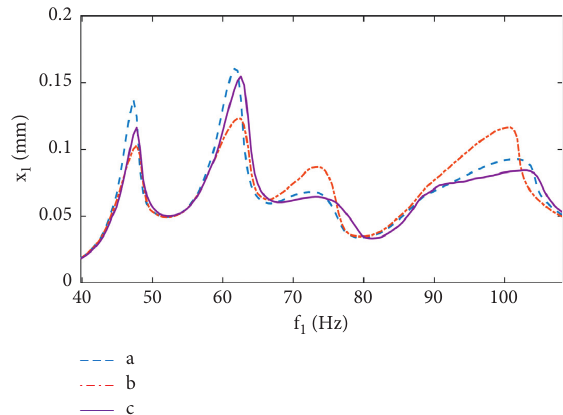
Figure 19: Comparison of effects of vibration suppression with different SFD configurations (a: front support of low-pressure shaft and front support of high-pressure shaft, b: rear support of low- pressure shaft and front support of high-pressure shaft, c: only front support of high-pressure shaft with clearance of